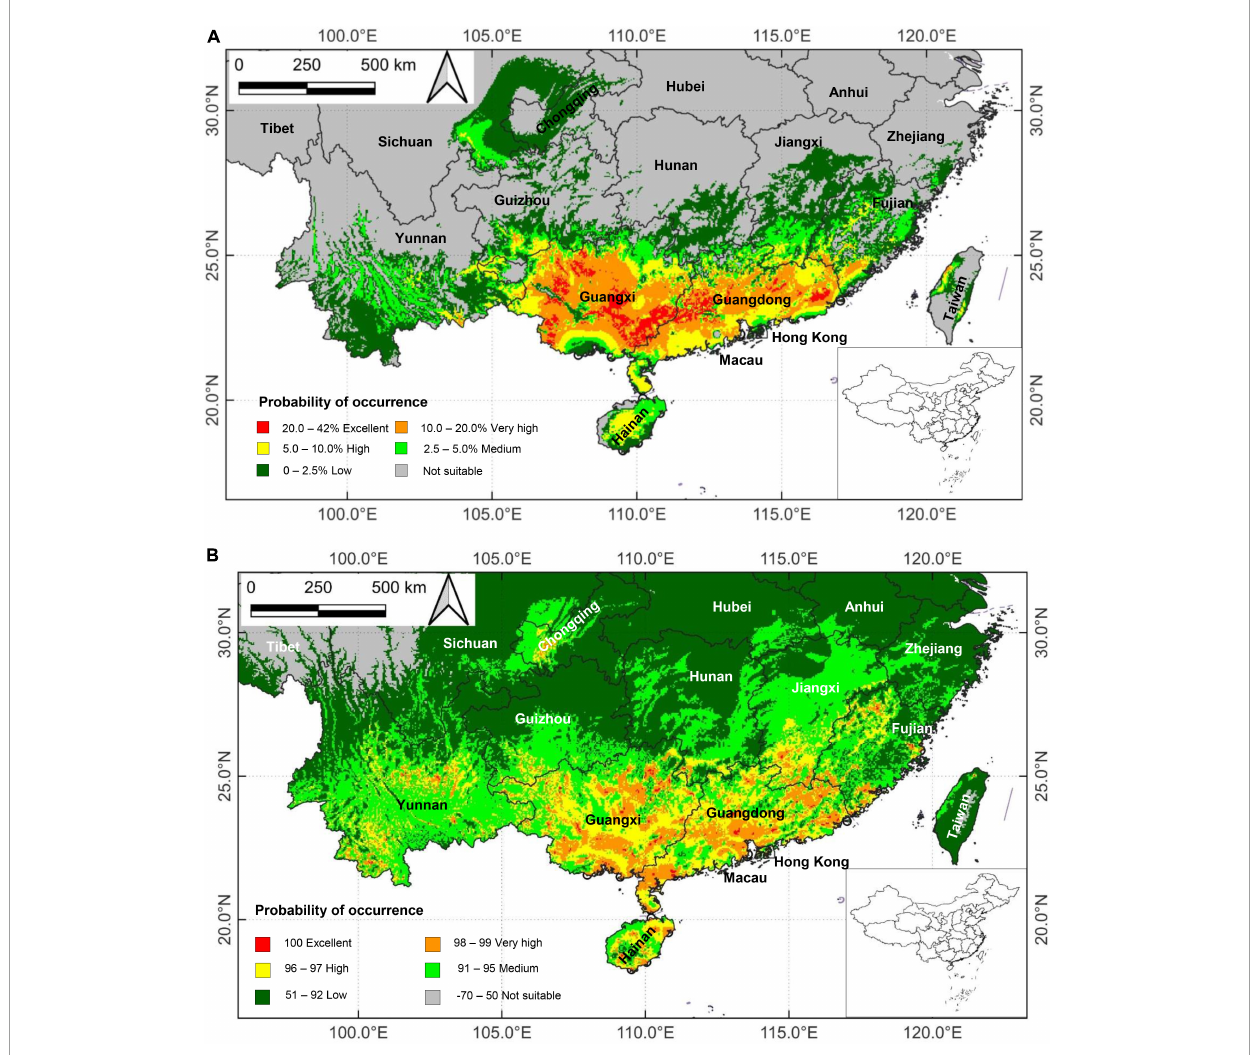
FIGURE4 Potential suitability areas of Mimosa bimucronata under the current climate scenario in China (1970–2000) generated by the: (A) BIOCLIM model; and (B) DOMAIN model. They are divided into six categories based on the calculated habitat suitability index. Red color denotes excellent suitability habitat, orange very high, yellow high, light green medium, dark green low, and gray not suitable.